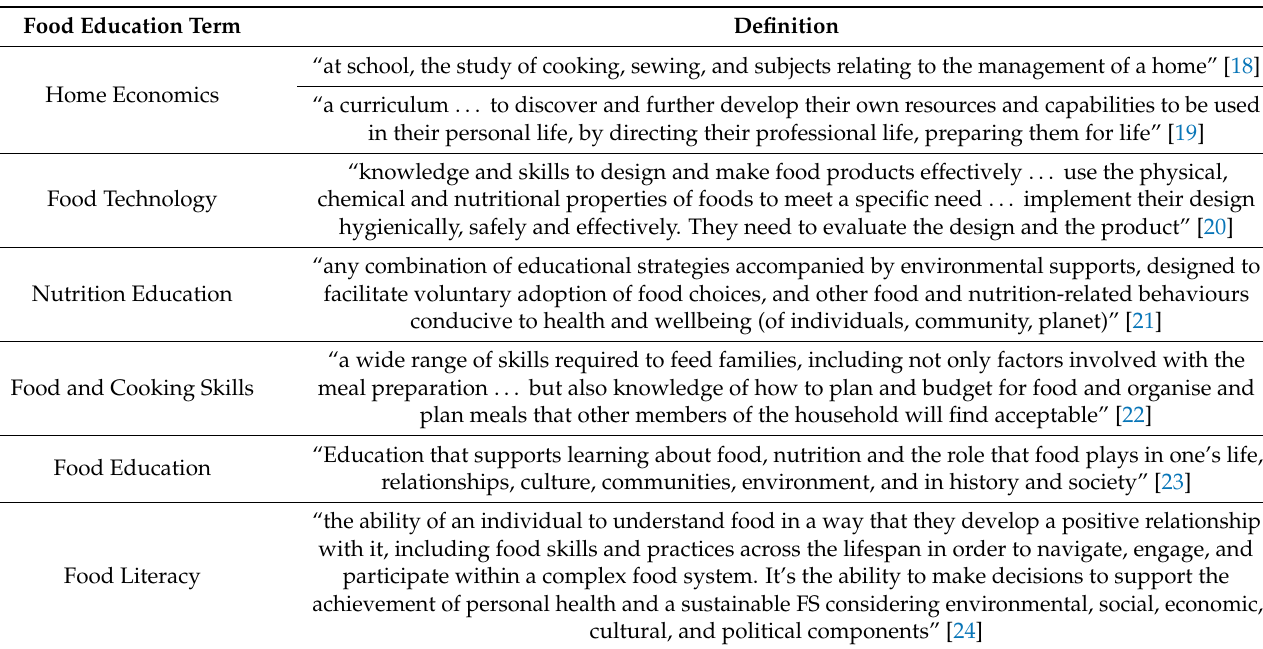
Table 1. Food education terms defined. Source: